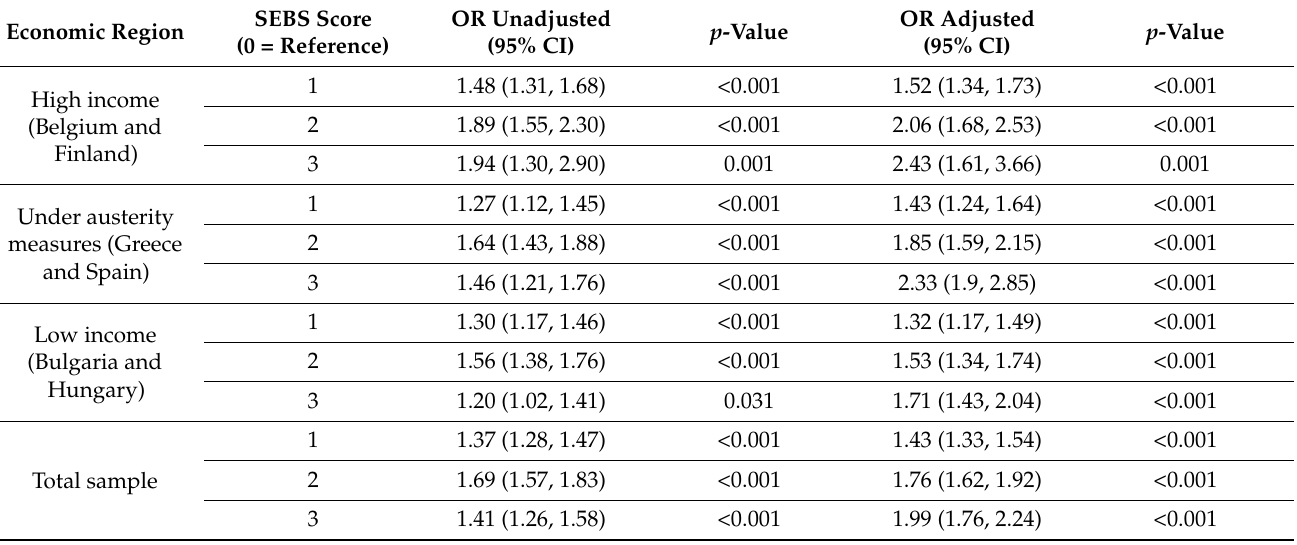
Table 4. SEBS score and the risk of being overweight or obese based on the country’s economic status.